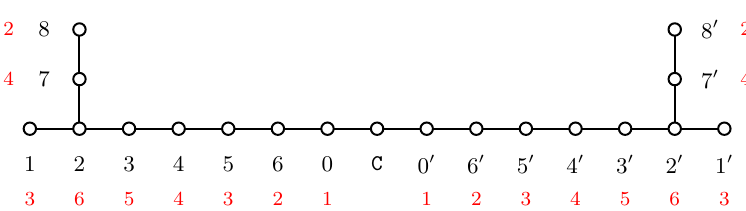
Figure 1. Extended Dynkin diagram for the II 1 ; 17 lattice, with labels showing the embedding of the extended Dynkin diagrams of E 8 + E 0 . The Kac marks are shown in 8